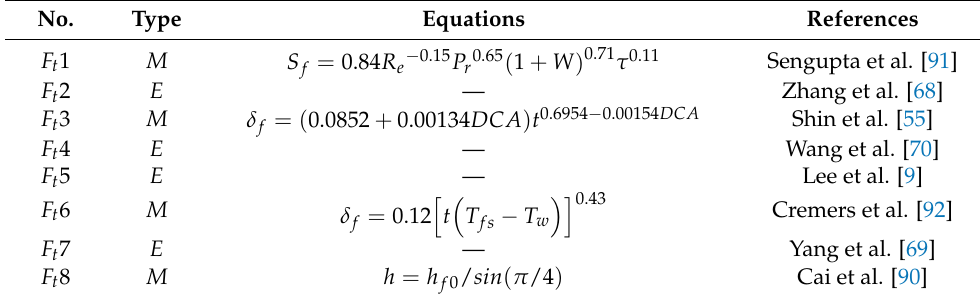
Table 5. Thickness of frost